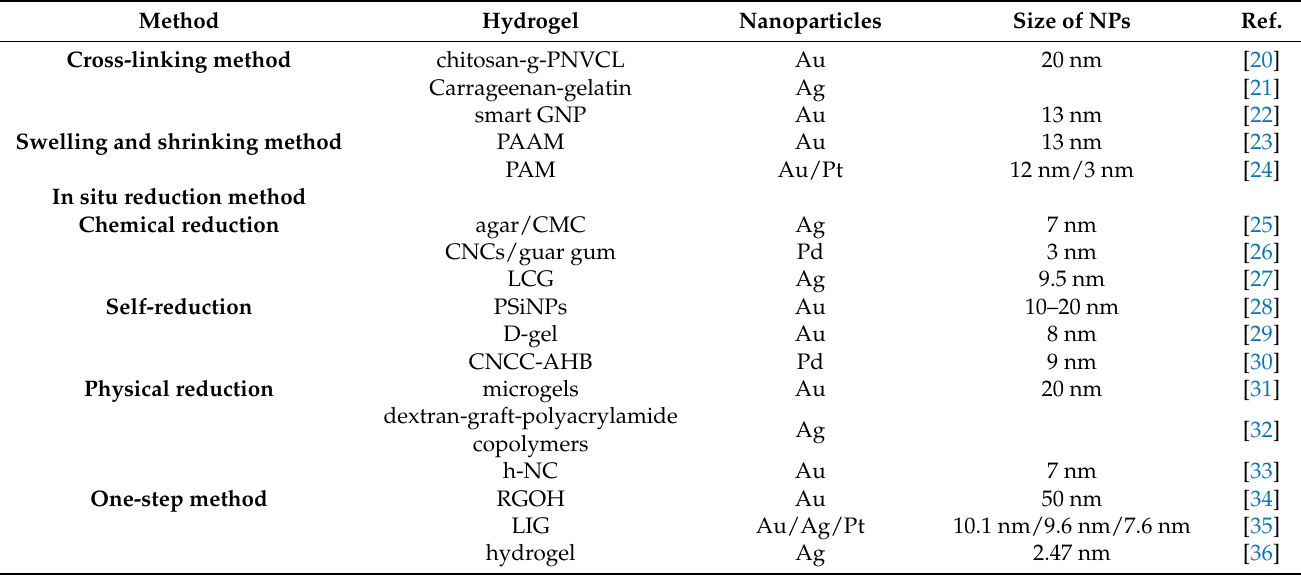
Table 1. Different methods for synthesis of the composite with nanoparticles and